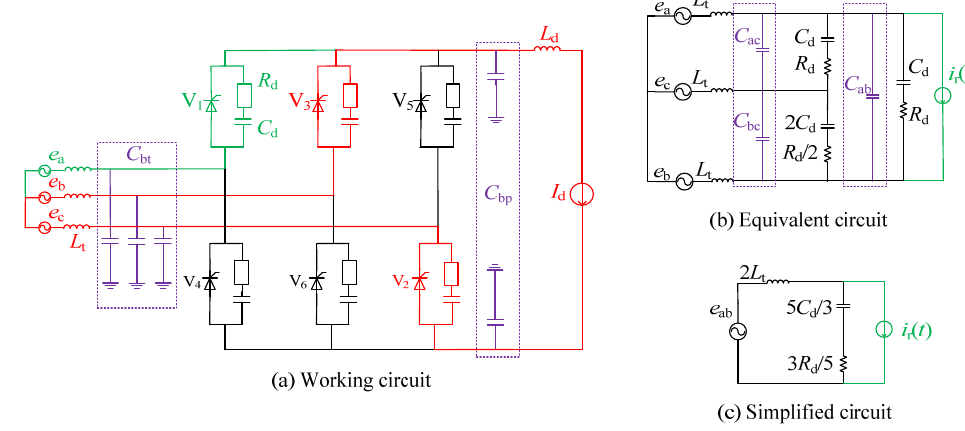
Figure 2. Conventional Model for Turn-off Process.